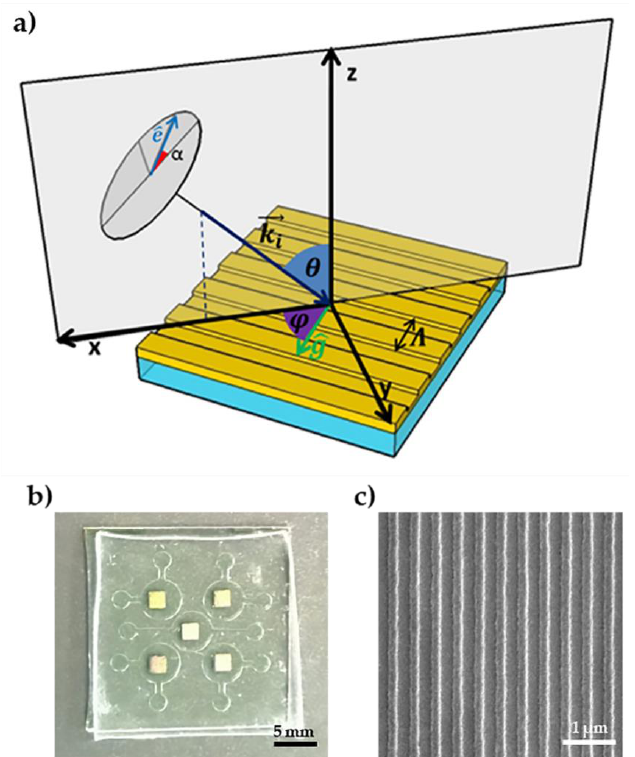
Figure 1. Conical mounting scheme and sensing unit. ( a ) Schematic representation of the grating-coupled SPR system based on phase interrogation. The x and z axes lay on the scattering plane. The grating wave vector 𝒈̂ forms an angle 𝝋 with the x -axis, defined as azimuth, while the incident light wave vector 𝒌 𝒊 ⃗⃗⃗ is incident at an angle 𝜽 from the normal to the grating surface, defined as the polar angle. The polarization 𝜶 is defined as the angle formed by the electric field versor 𝒆̂ from the scattering plane. 𝚲 indicates the period of the grating. ( b ) Final chip integrated in the microfluidic chamber. Each glass slide is divided into five sensing areas with independent chambers. ( c ) Representative SEM image of a gold grating prior to microfluidic chamber bonding.